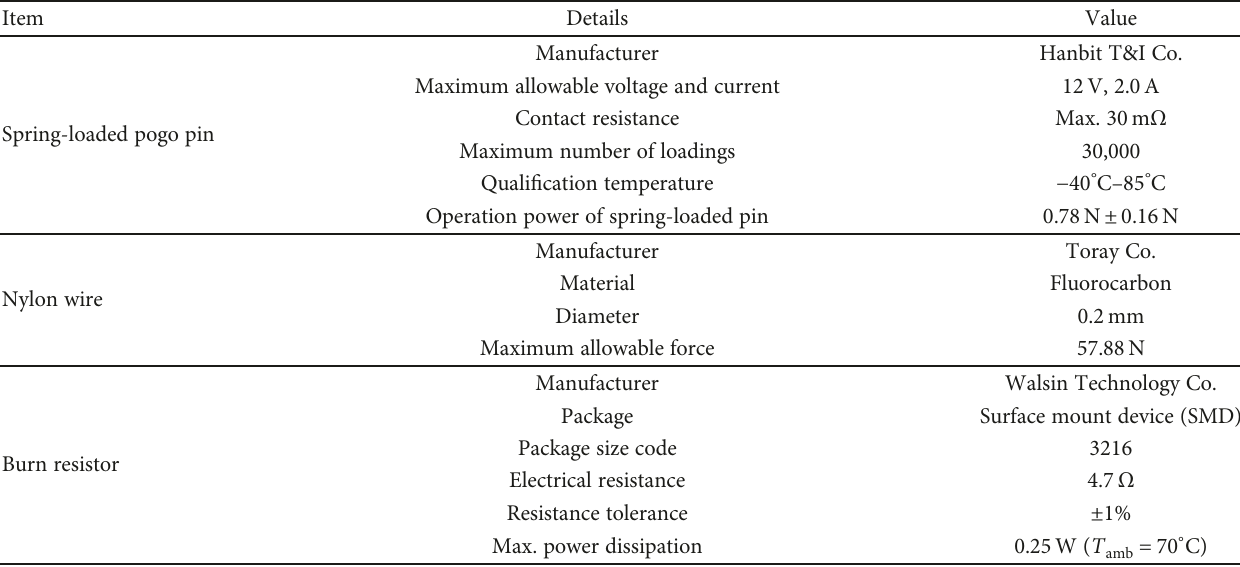
Table 1: Speci fi cations of the spring-loaded pogo pin, nylon cable, and burn resistor.